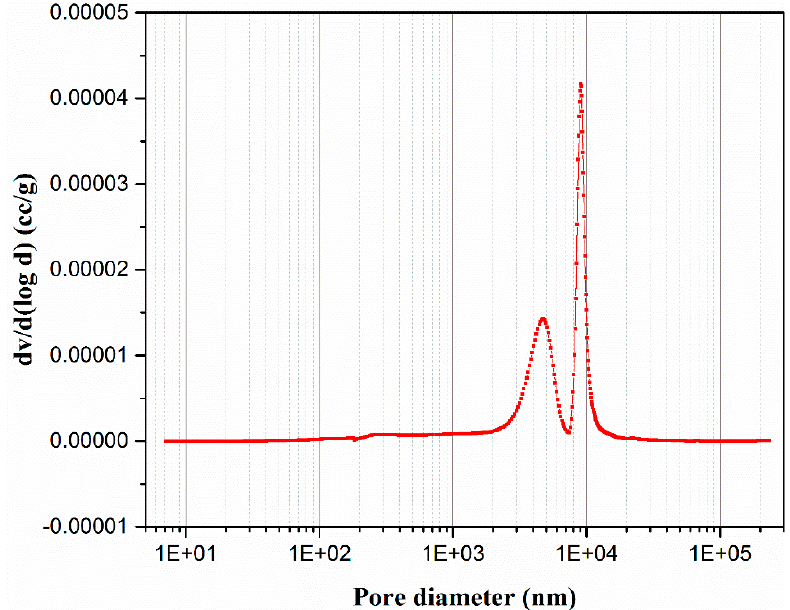
Figure 10. Pore diameter distribution curve of talcum-fly ash support.